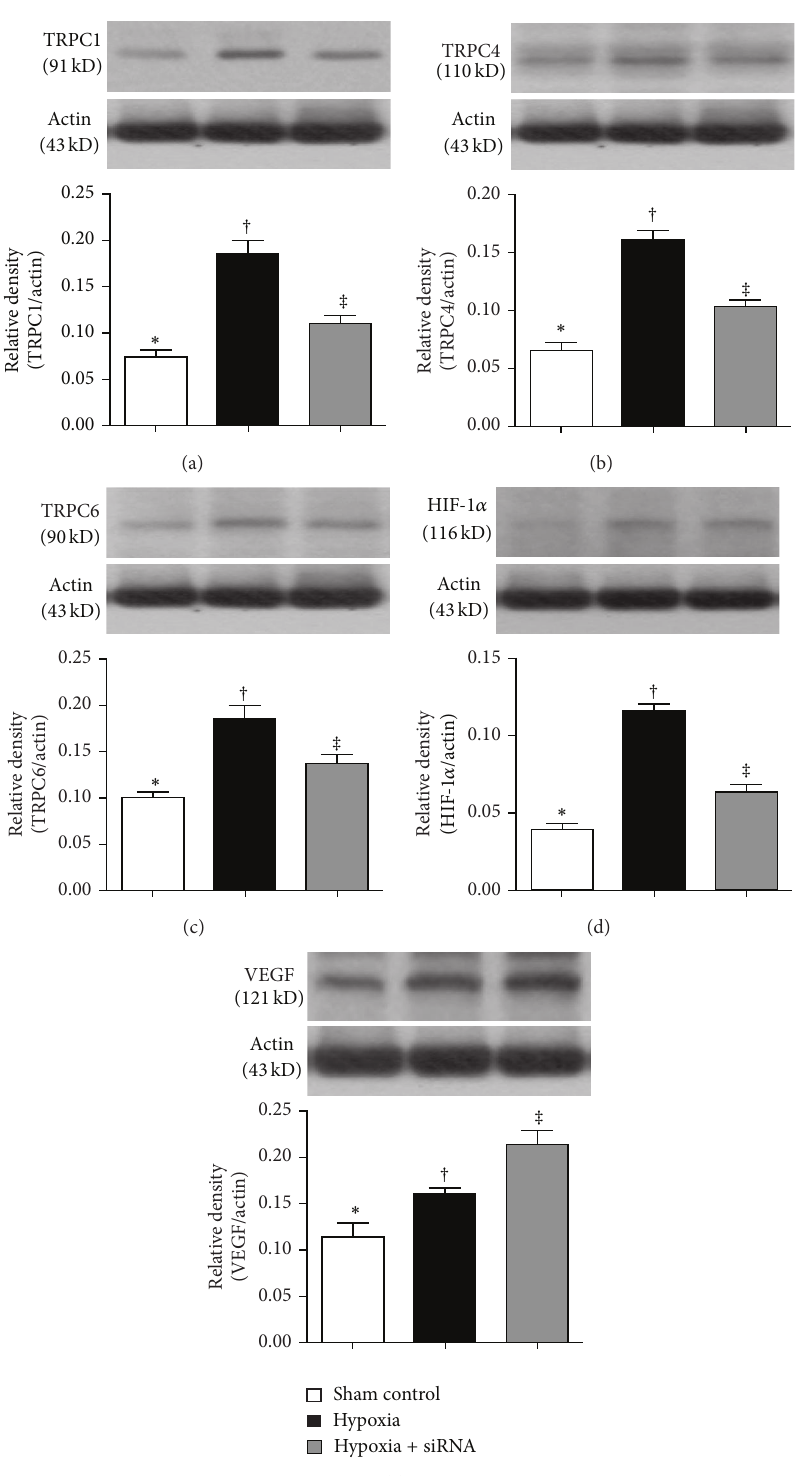
Figure 7: Protein expressions of TRPCs, HIF-1 𝛼 , and VEGF of lung parenchyma by day 28 after hypoxia-induced pulmonary arterial hypertension (PAH) ( 𝑛 = 10 ). (a) Protein expression of TRPC1, ∗ versus other groups with different symbols ( ∗ , † , ‡ ), 𝑃 < 0.001 . (b) Protein expression of TRPC4, ∗ versus other groups with different symbols ( ∗ , † , ‡ ), 𝑃 < 0.01 . (c) Protein expression of TRPC6, ∗ versus other groups with different symbols ( ∗ , † , ‡ ), 𝑃 < 0.01 . (d) Protein expression of HIF-1 𝛼 , ∗ versus other groups with different symbols ( ∗ , † , ‡ ), 𝑃 < 0.001 . (e) Protein expression of vascular endothelial growth factor (VEGF), ∗ versus other groups with different symbols ( ∗ , † , ‡ ), 𝑃 < 0.01 . Statistical analysis in ((a) to (e)) using one-way ANOVA, followed by Bonferroni multiple comparison post hoc test. Symbols ( ∗ , † , ‡ ) indicate significance (at 0.05